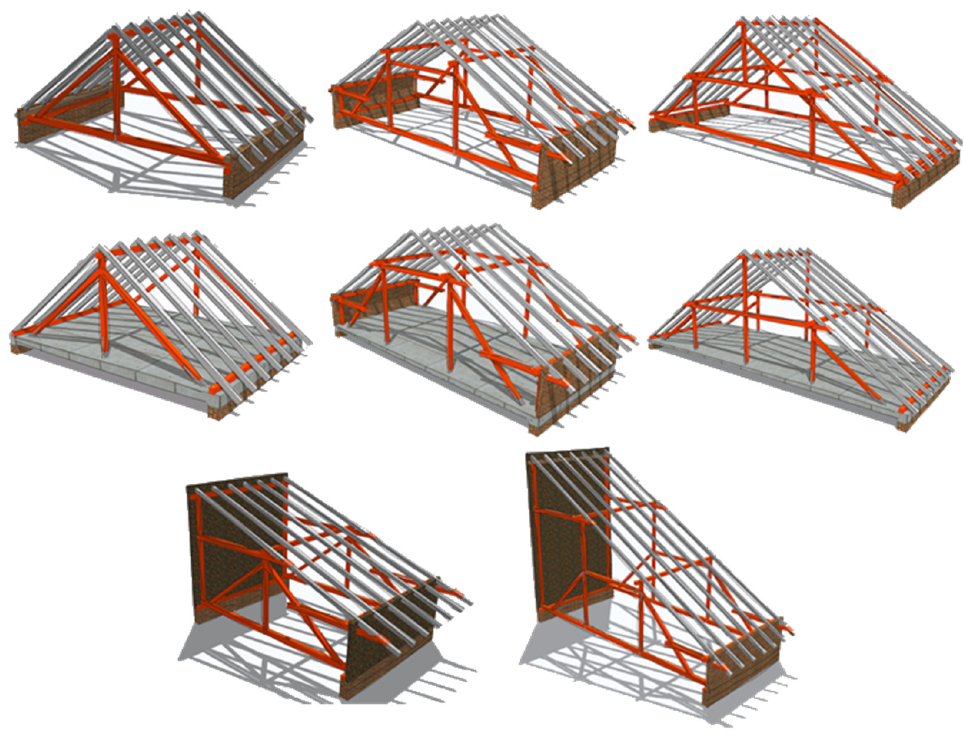
Figure 2. Typical timber roof structure systems in continental Croatia.